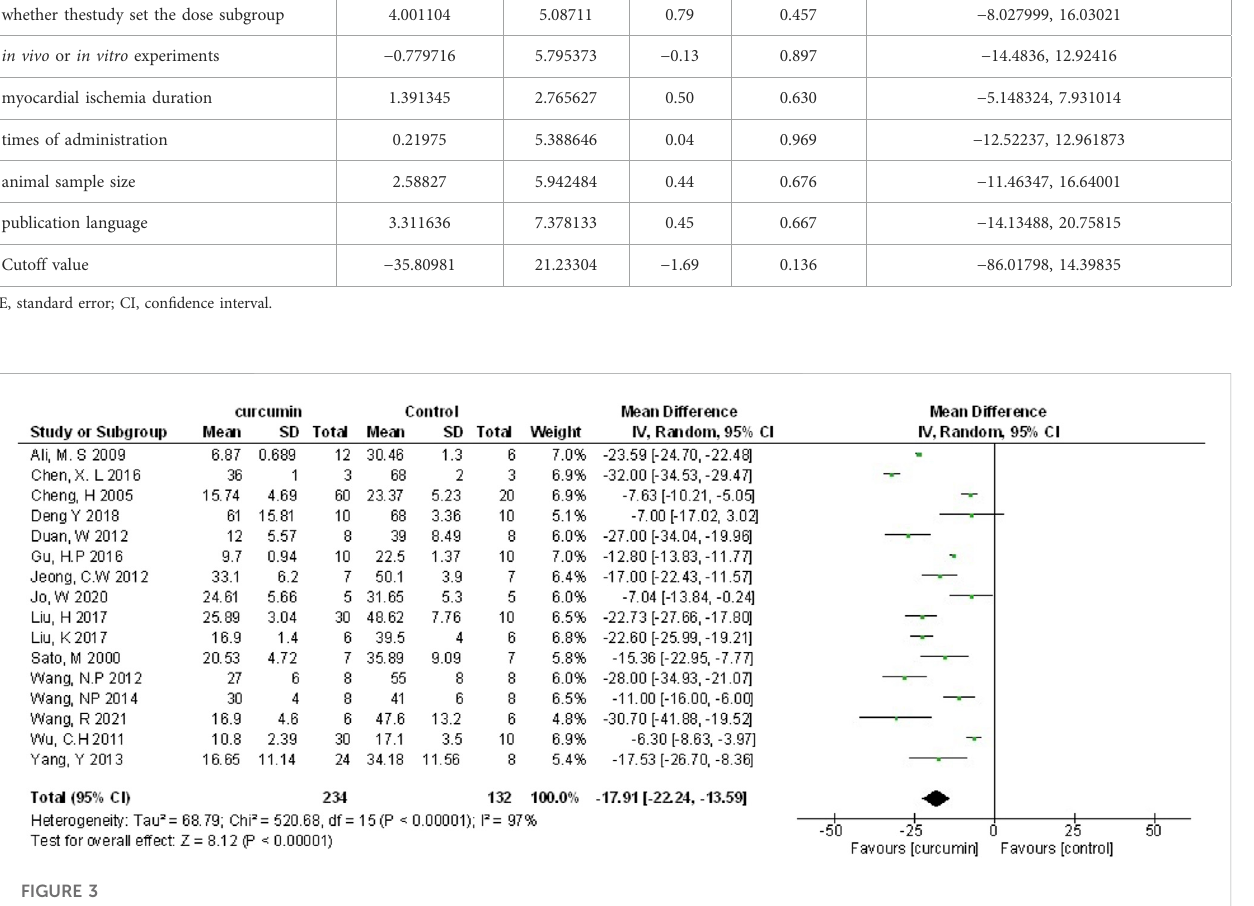
The meta-analysis results of the effect of curcumin on MI